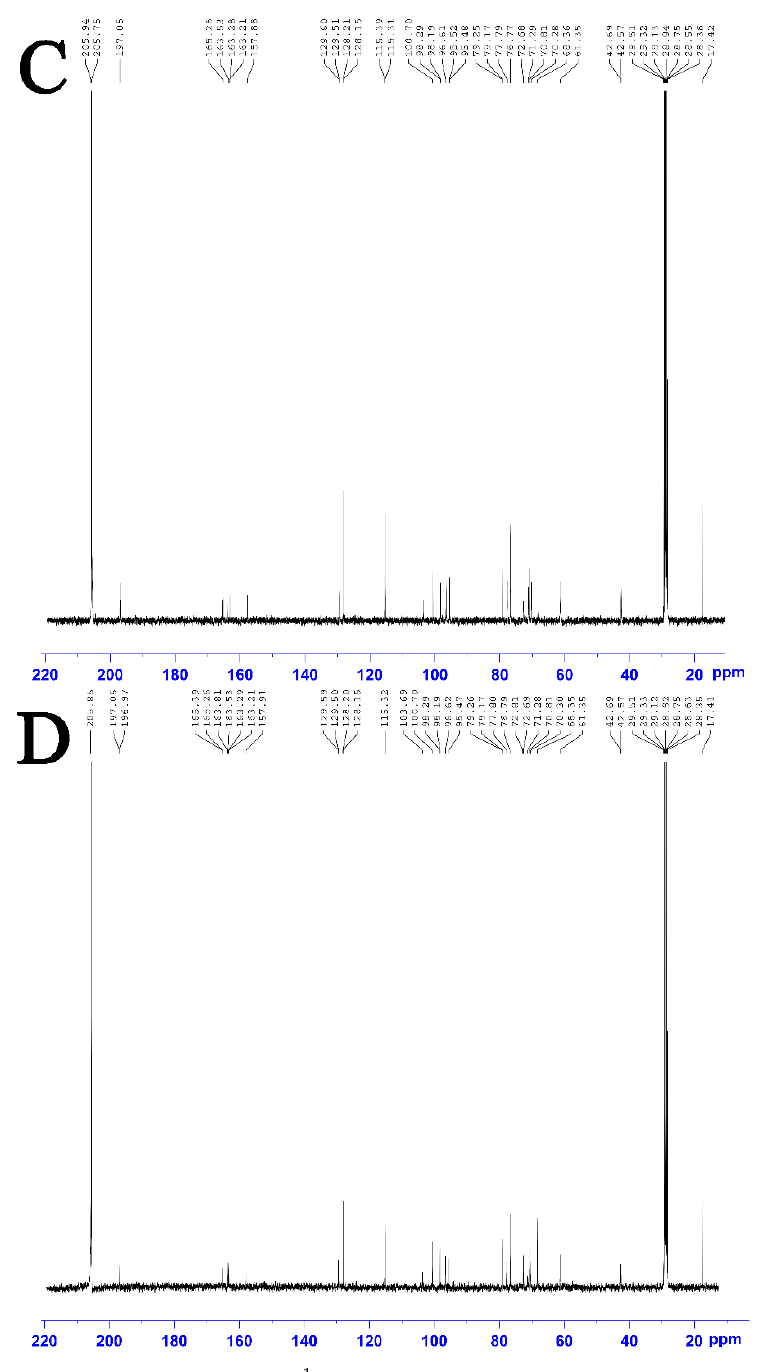
Figure 7. NMR spectrum. ( A ) 1 HNMR spectrum of refined naringin products; ( B ) 1 H NMR. Spectrum of naringin standard; ( C ) 13 C NMR spectrum of refined naringin products; ( D ) 13 C NMR spectrum of naringin standard.